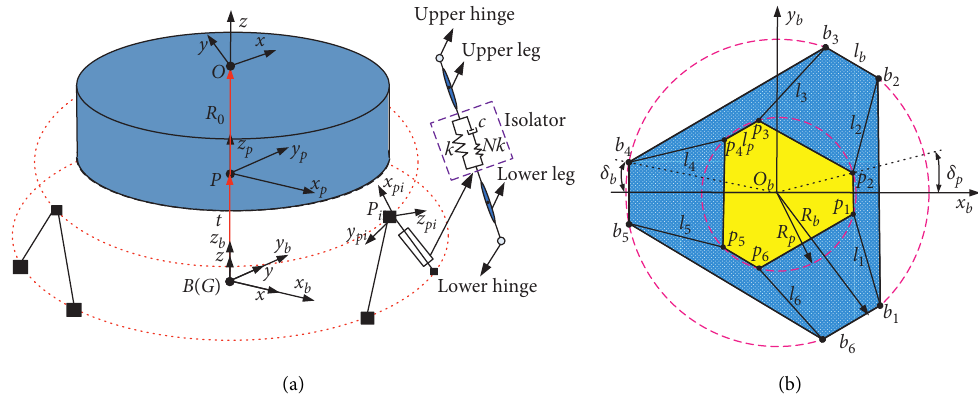
Figure 2: Schematic of the microvibration suppression device. (a) Simplified model. (b) Top view of the model.